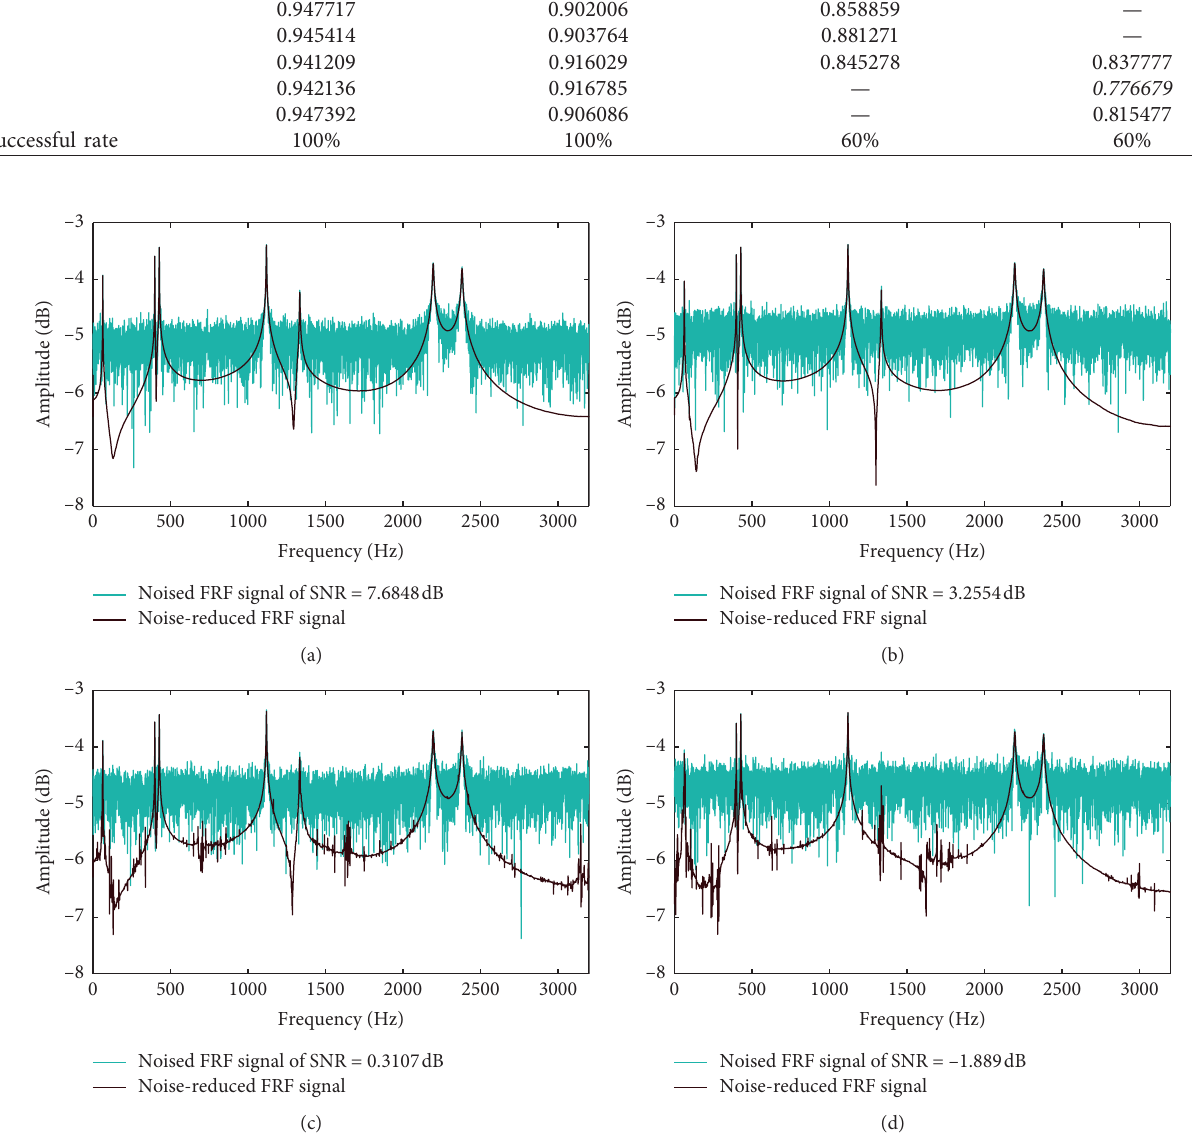
Figure 11: Overlays of the FRFs with various SNR values. (a) Overlay of the FRFs with SNR � 7.68dB. (b) Overlay of the FRFs with SNR � 3.25dB. (c) Overlay of the FRFs with SNR � 0.31dB. (d) Overlay of the FRFs with SNR � −